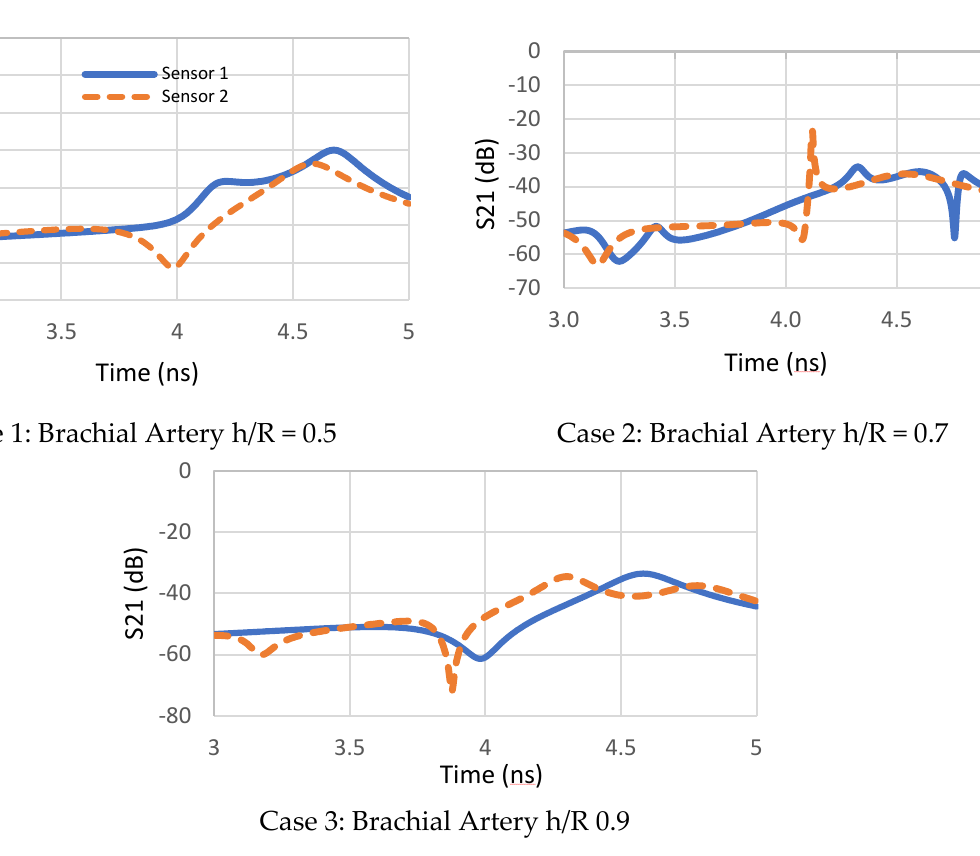
Figure 15. Three cases of simulation results of transmission coefficient variation in the time domain for the human artery of h/R ratios = 0.5, 07 and 0.9.